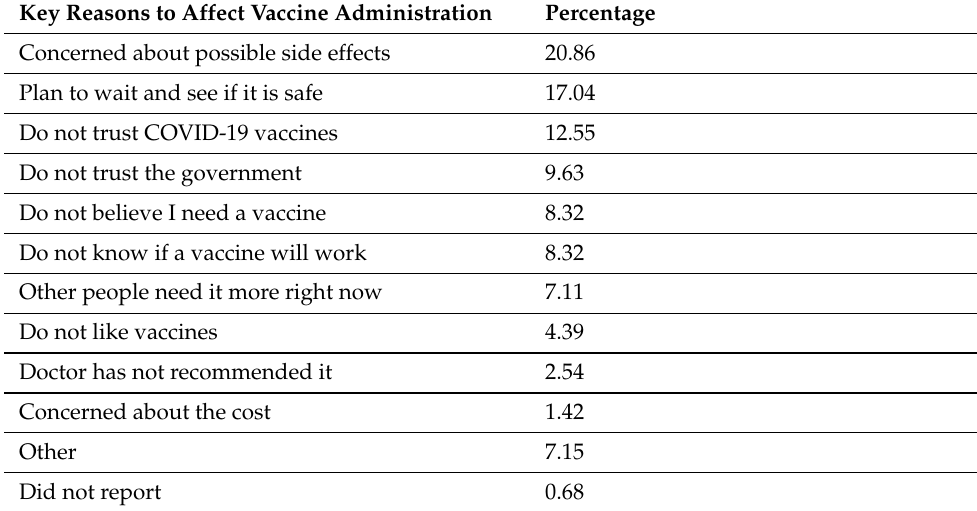
Table 5. Reasons to decline COVID-19 vaccination in the US (Data source: